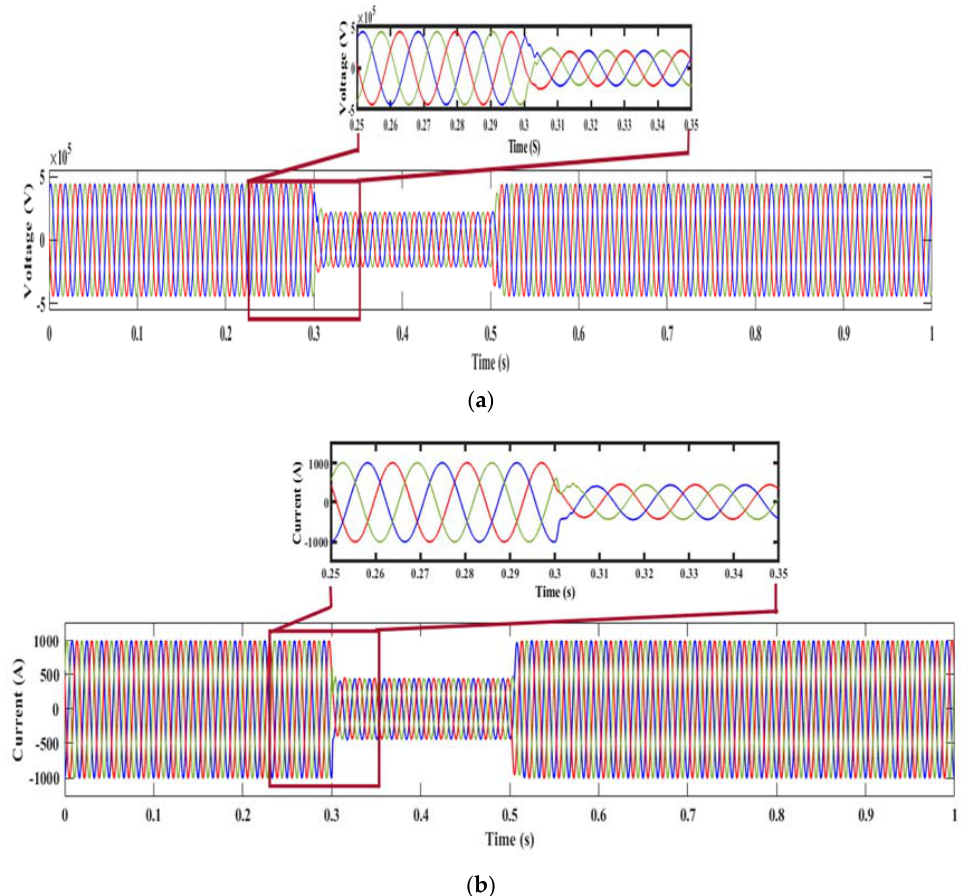
Mathematics 2022 , 10 , x FOR PEER REVIEW Figure 7. Analysis of ( a ) Bus 5 voltage and ( b ) Bus 5 current under power swing conditions.